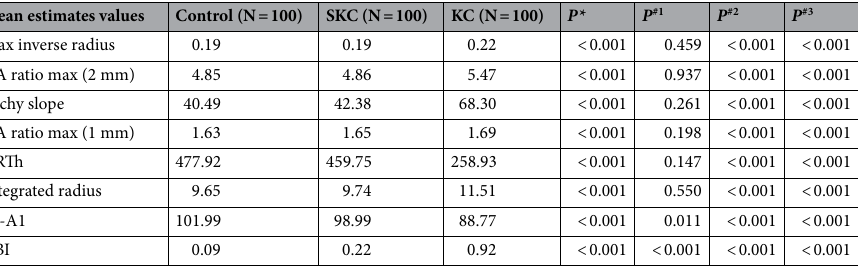
Table 2. The results of linear mixed-effect model adjusting for IOP and CCT. SKC Subclinical keratoconus, KC Keratoconus, DA Deformation amplitude, ARTh Ambrósio’s relational thickness horizontal, bIOP Biomechanical corrected intraocular pressure, SP-A1 Stiffness parameter at the first applanation, CBI Corvis biomechanical index. *Linear mixed-effect model; #1 control versus SKC; #2 control versus KC; #3 SKC versus KC.